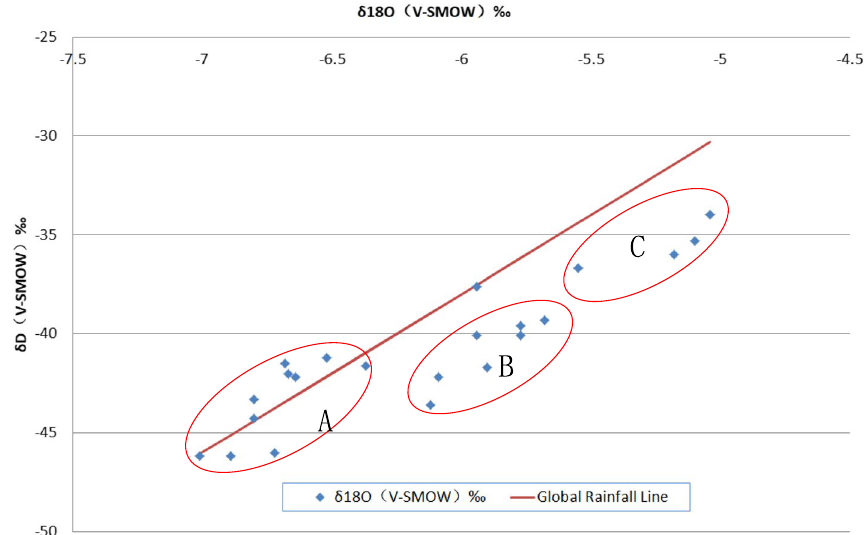
Fig. 3 Deuterium and oxygen isotope analysis